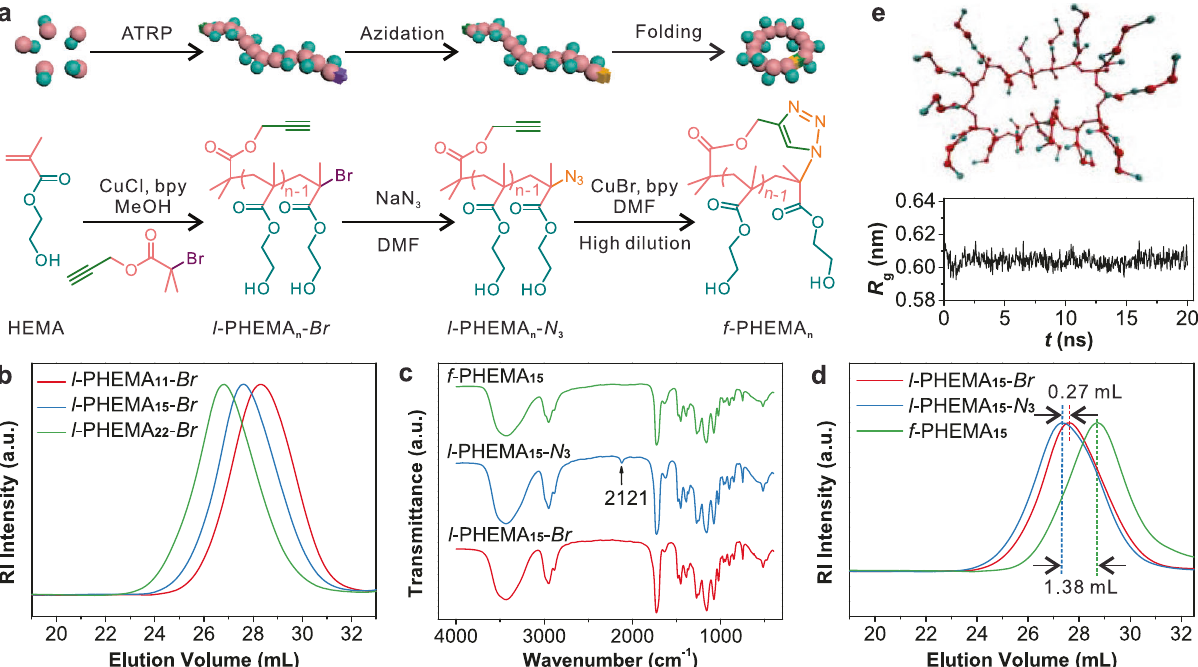
Fig. 1 Synthesis and folding of PHEMA. a Scheme of the synthesis of l -PHEMA n - Br and its azidation and folding into the cyclic topology. b GPC curves (eluent: DMF; standard: PMMA) of l -PHEMA n - Br with different repeating units. c FTIR spectra, and d GPC curves of l -PHEMA 15 - Br , l -PHEMA 15 - N 3 , and f -PHEMA 15 . e The top and bottom panels show a simulation snapshot and the time evolution of R g of a single f -PHEMA 15 in pure water, respectively.